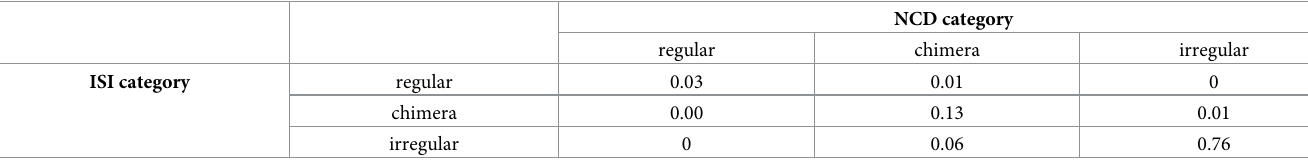
Table 1. Network state classification by ISI statistics and NCD